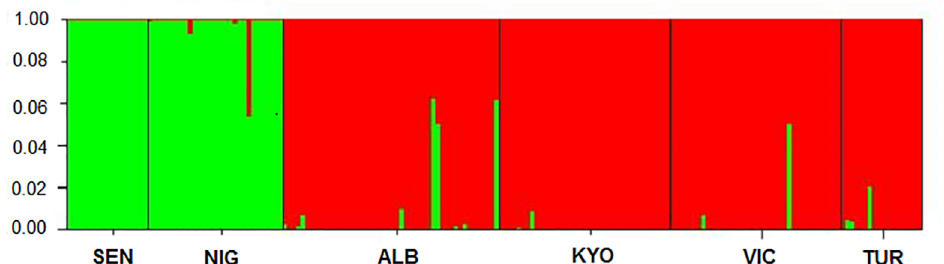
Fig 3. STRUCTURE bar plot showing the genetic assignment (K = 2) of West (Green) and East (red) African Nile perch, Lates niloticus ,populations. The X-axis represents the sampling locations SEN- Senegal, NIG- Lake Kainji on the Niger River, ALB- Lake Albert, KYO- Lake Kyoga, VIC- Lake Victoria and TUR- Lake Turkana.